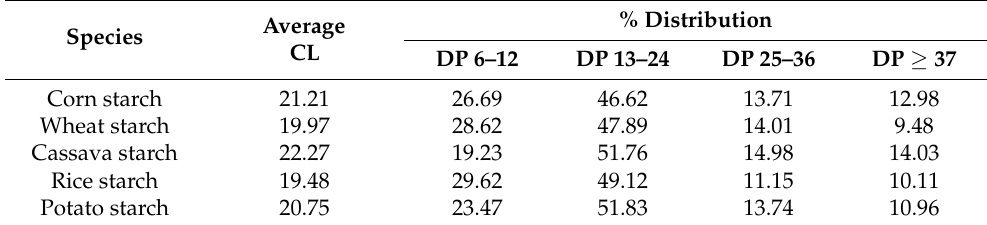
Table 1. Branched chain length distributions of